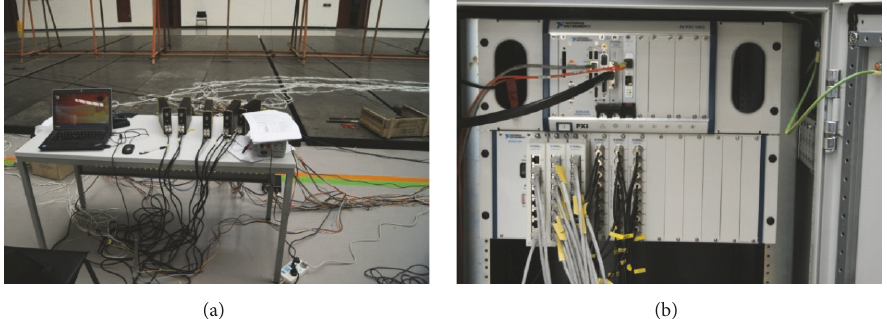
Figure 6: NI data acquisition system: (a) strain acquisition system and (b) displacement and acceleration acquisition